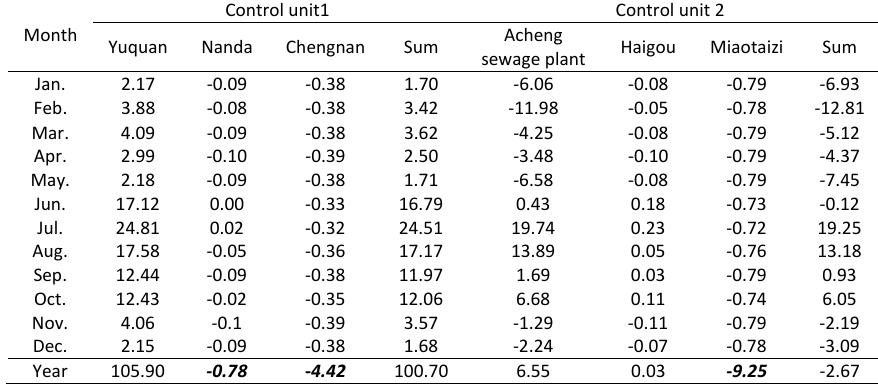
Table 7: Surplus water environmental capacity of NH 3 ‐ N at each outlet and control unit (ton) Control unit1 Month